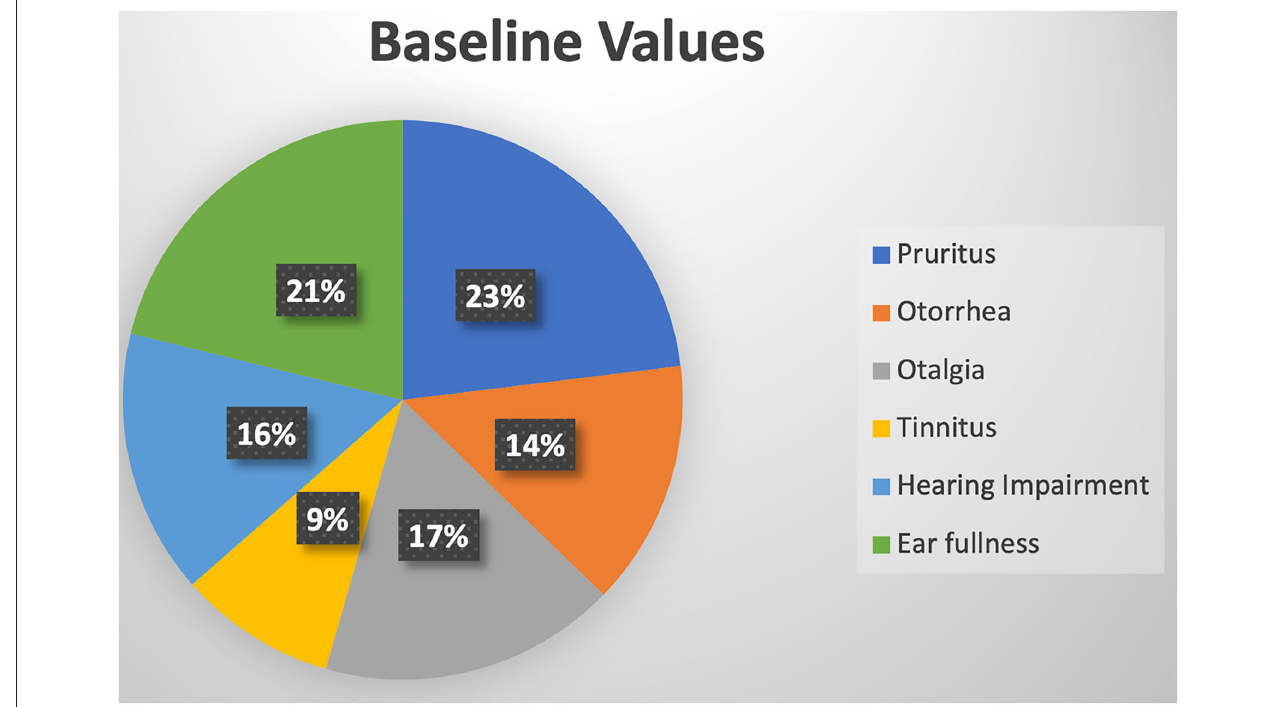
FIGURE 5 | Ear symptoms before medication in the included